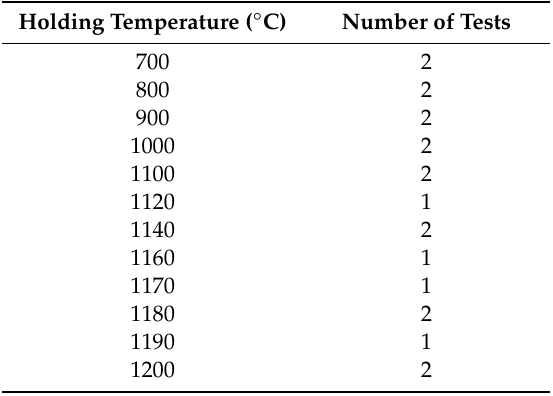
Table 1. Number of tests at each holding